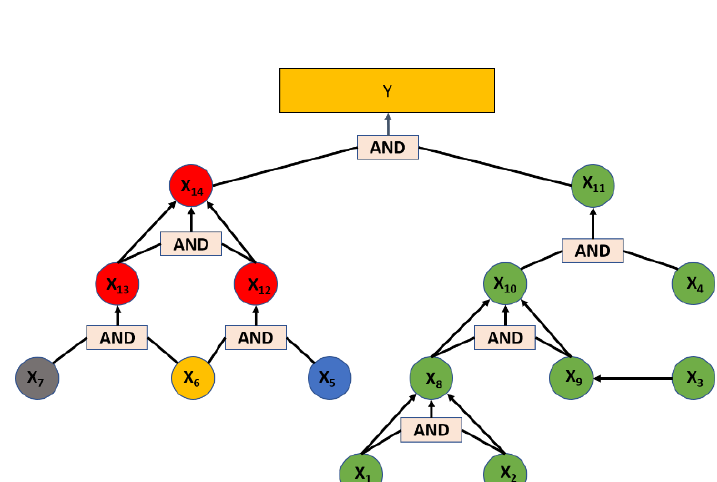
Table 3. Level and color assignment of variables. Table 4. The original data information of spare part No. 144.